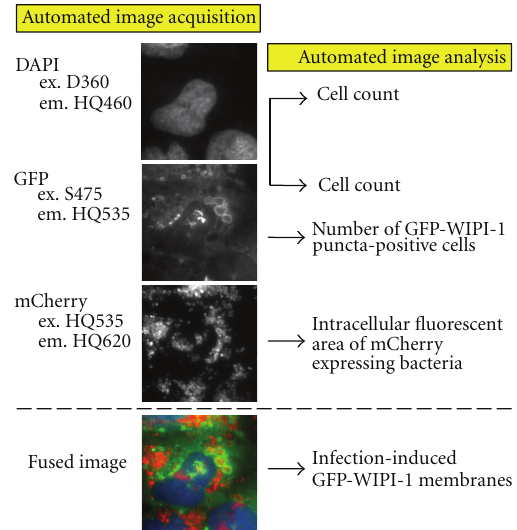
Figure 3: Automated image acquisition and analysis of stably expressing GFP-WIPI-1 U2OS cells with mCherry-expressing Staphylococci. Fluorescence images (middle panel) were automatically acquired using di ff erent emission/excitation filters for DAPI, GFP, and mCherry (left panel). DAPI and GFP images were used to automatically detect individual cells, and GFP images were used for detecting and analyzing GFP- WIPI-1 puncta formation (indicated in the right panel). Additionally, for each individual cell the bacterial area was determined (indicated in the right panel) and a fused image was further used to determine the number of cells harboring WIPI-1 positive autophagosome-like vesicles entrapping Staphylococci